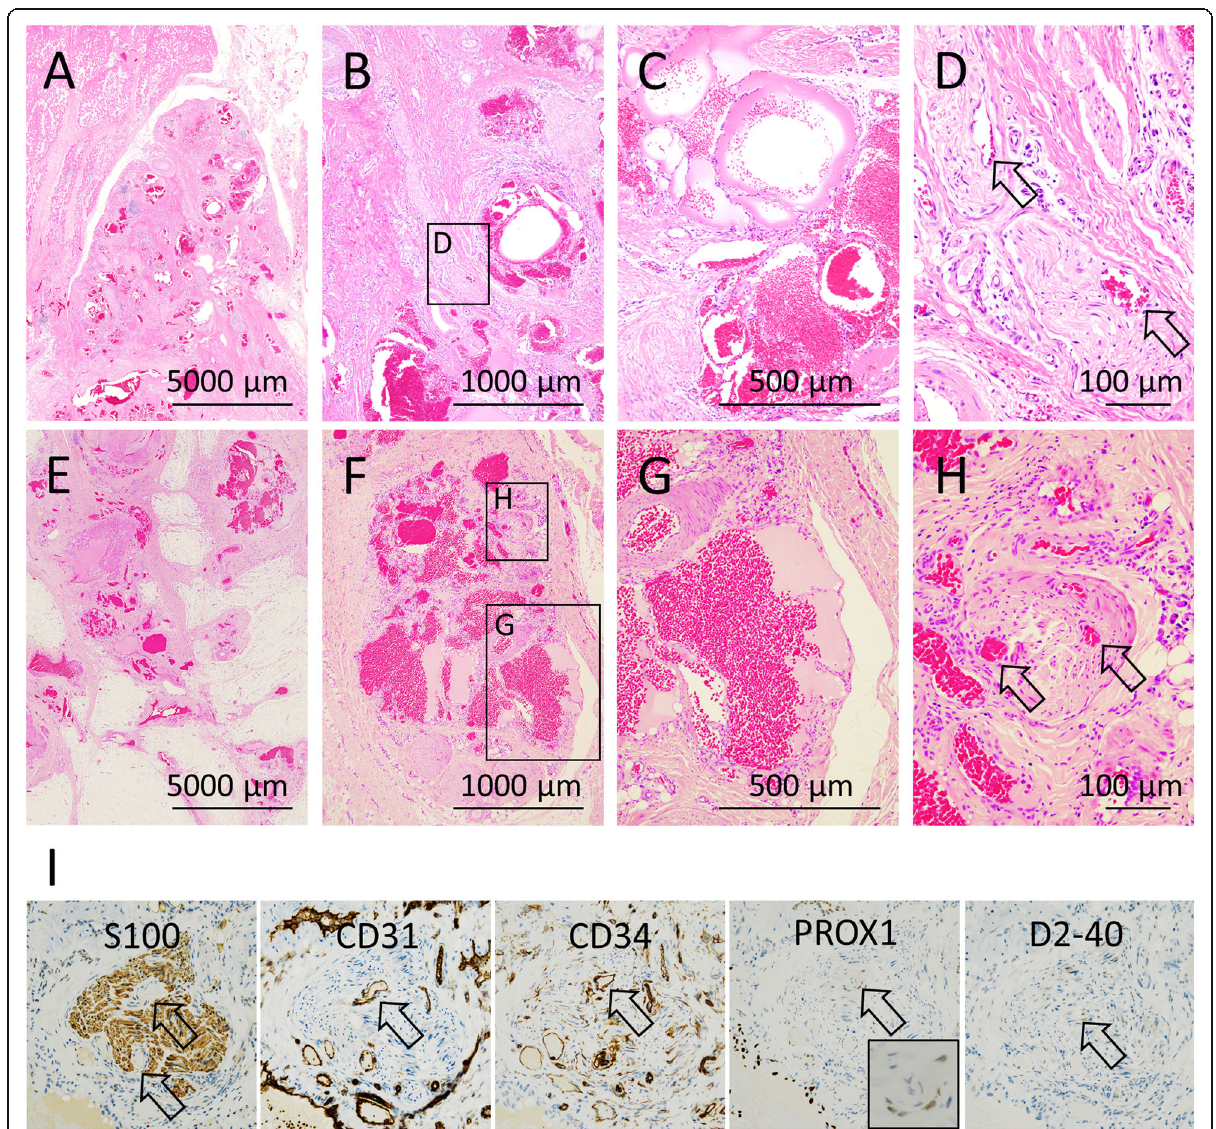
Fig. 2 Histology and immunohistochemical analysis of FAVA. A-H Representative histological findings in PIK3CA-mutation case ( A-D ) and PIK3CA- wild type (wt) case ( E-H ). Vascular malformation and adipose and dense fibrous tissue ( A, E ; lower magnification and B, F ; higher magnification). Clusters of vascular channels with thin-walled back-to-back blood-filled sacs ( C, G ). Nerve containing enlarged vessels ( D, H arrows). I Serial sections of a nerve containing enlarged vessels ( H ) stained for S100, CD31, CD34, PROX1, and D20-40 ( arrows indicated abnormal vessels in nerve)